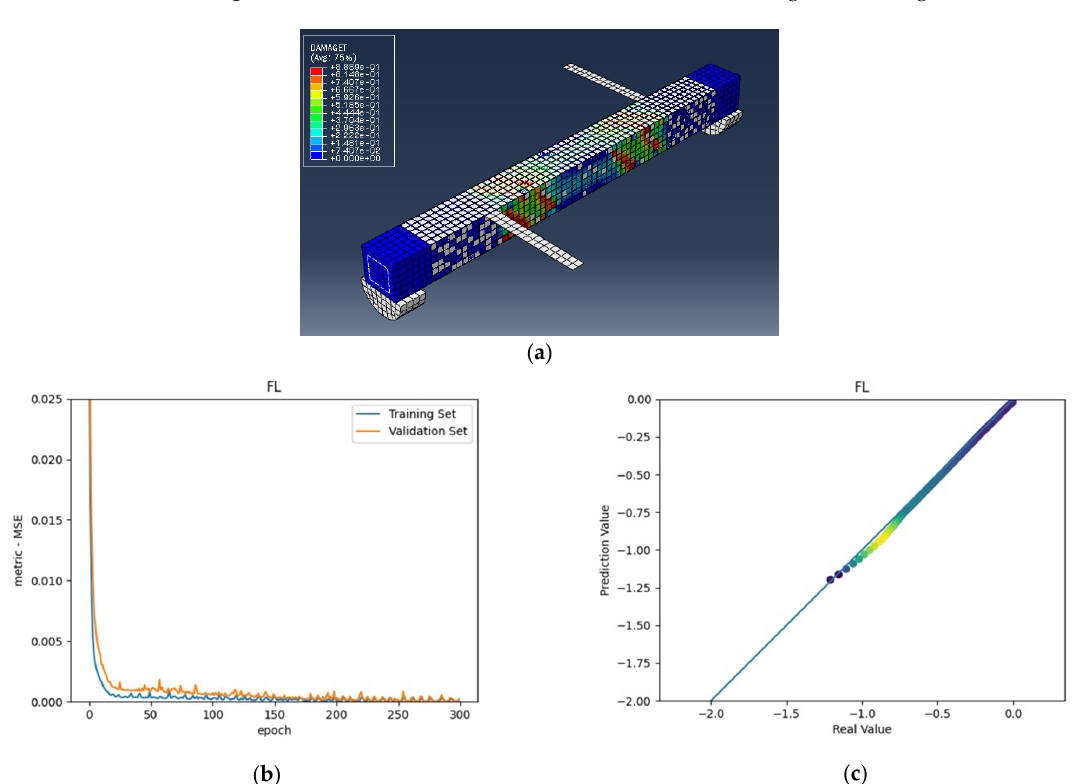
Figure 7. ( a ) FL beam under combined torsion and bending, ( b ) Training loss, ( c ) Accuracy.